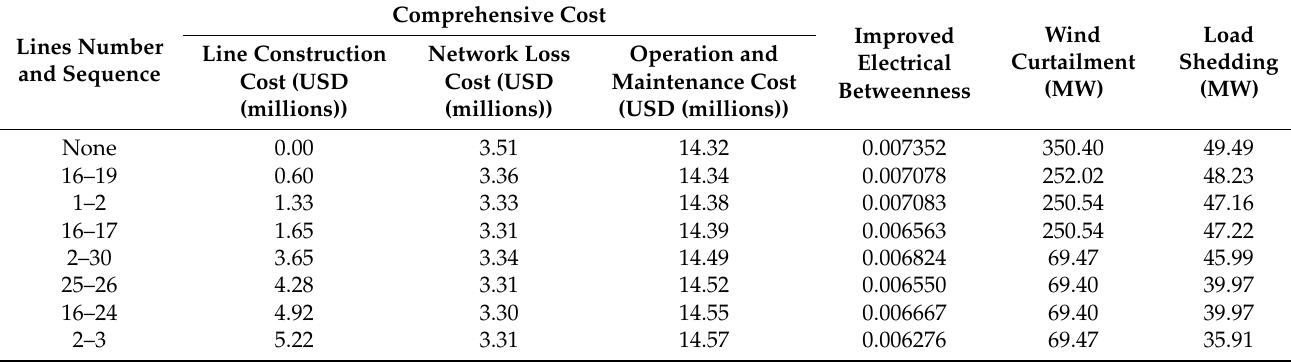
Table 13. TNEP scheme of DQN in modified New England 39-bus